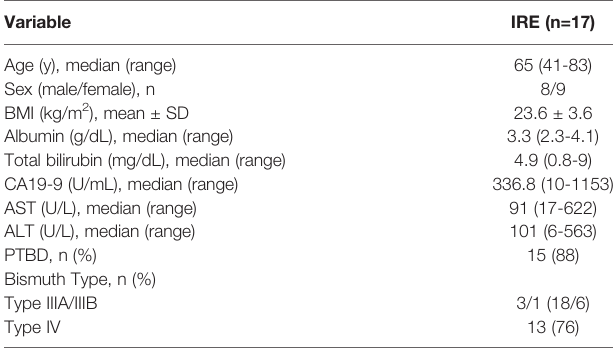
TABLE 1 | Baseline characteristics of patients before IRE.